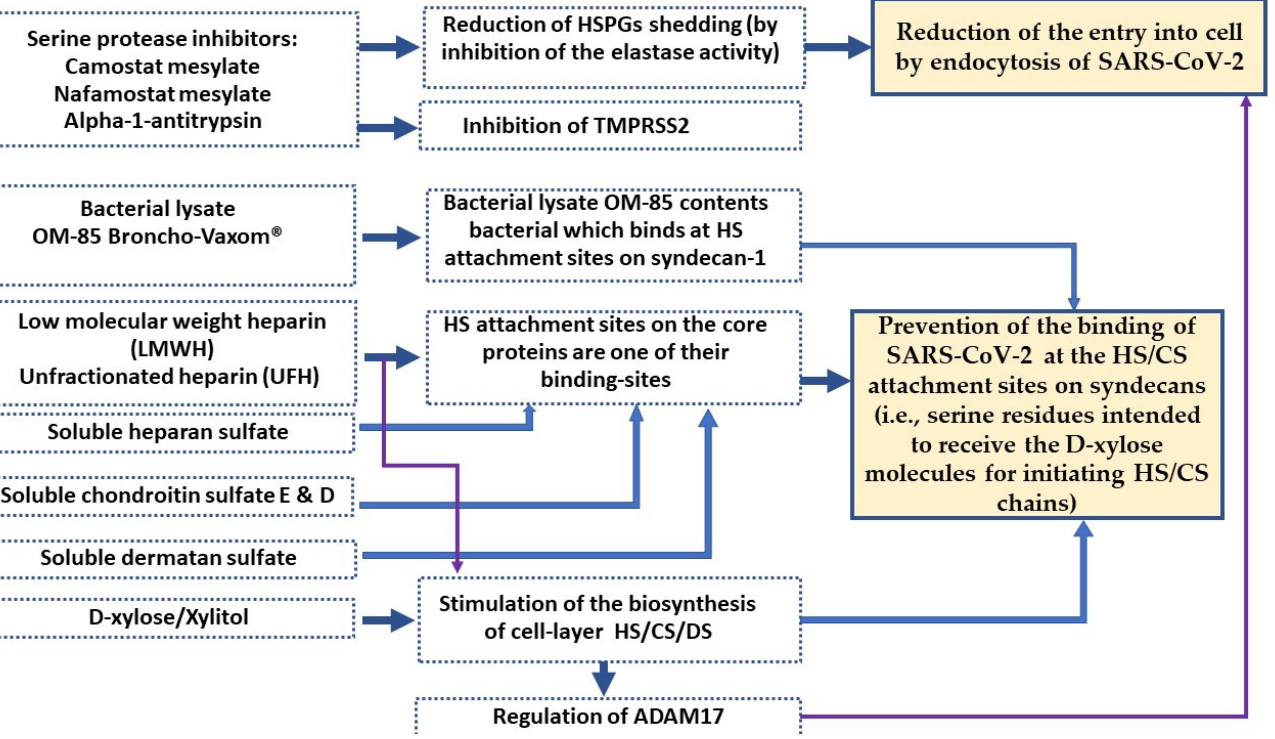
Figure 2. Potential mechanisms of action of each inhibitor during COVID-19.